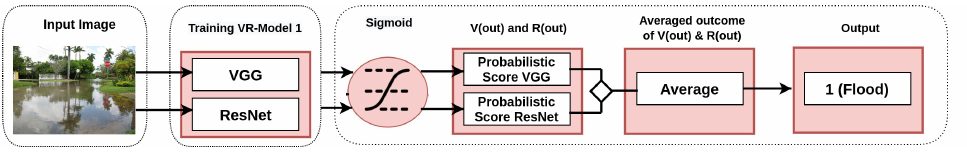
Figure 2. Processing steps of VRBagged-Net for an individual input